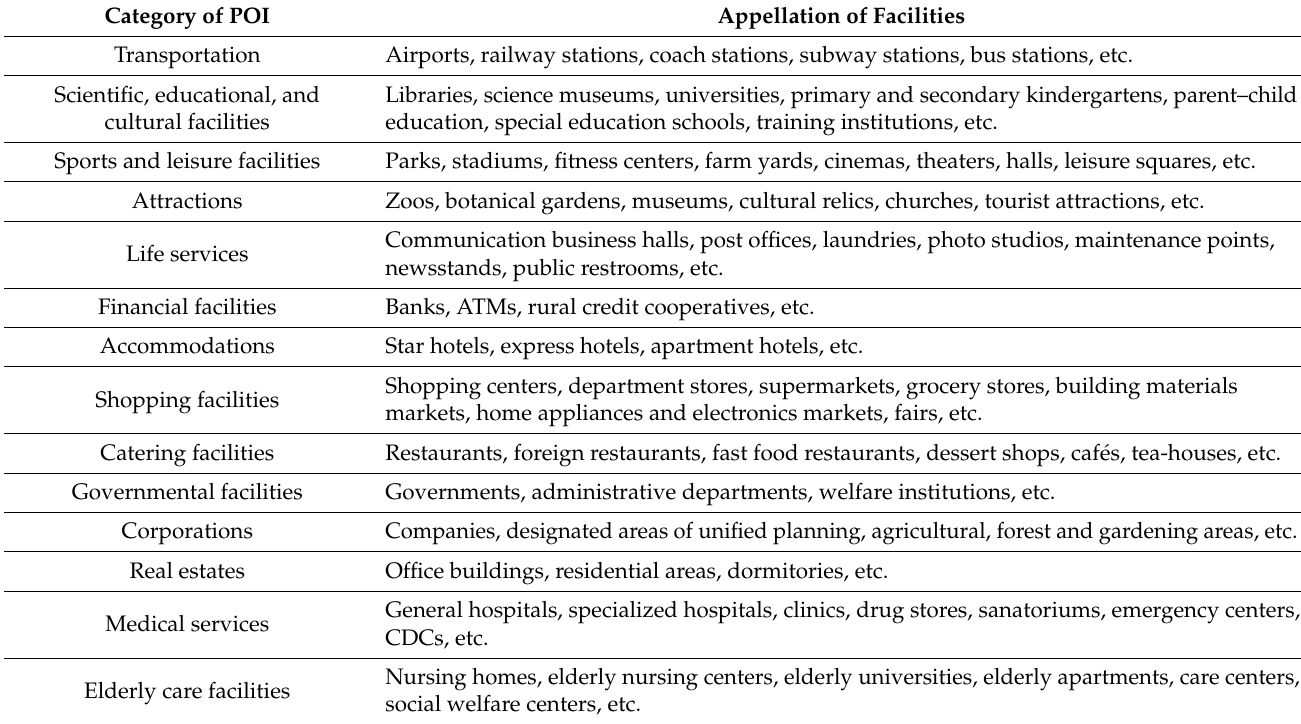
Table 1. Categorization and appellation of relevant point of interest data of various urban facilities for Wuhan,